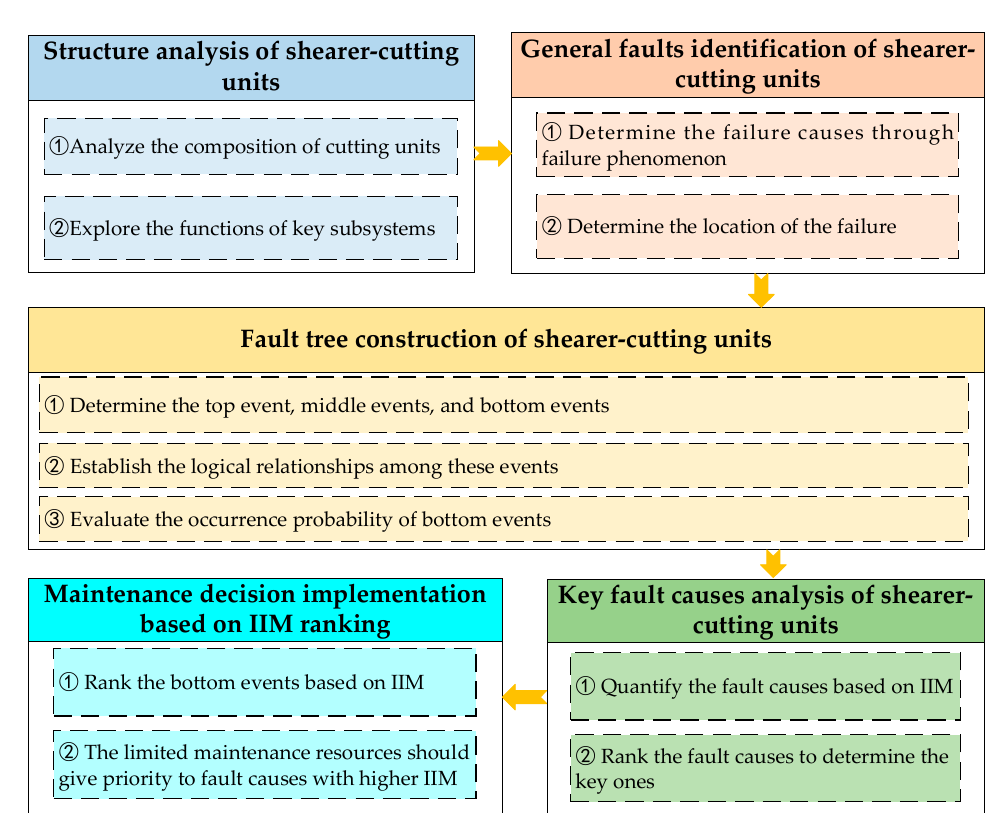
Figure 1. The framework of IIM-based fault analysis method for shearer-cutting units .